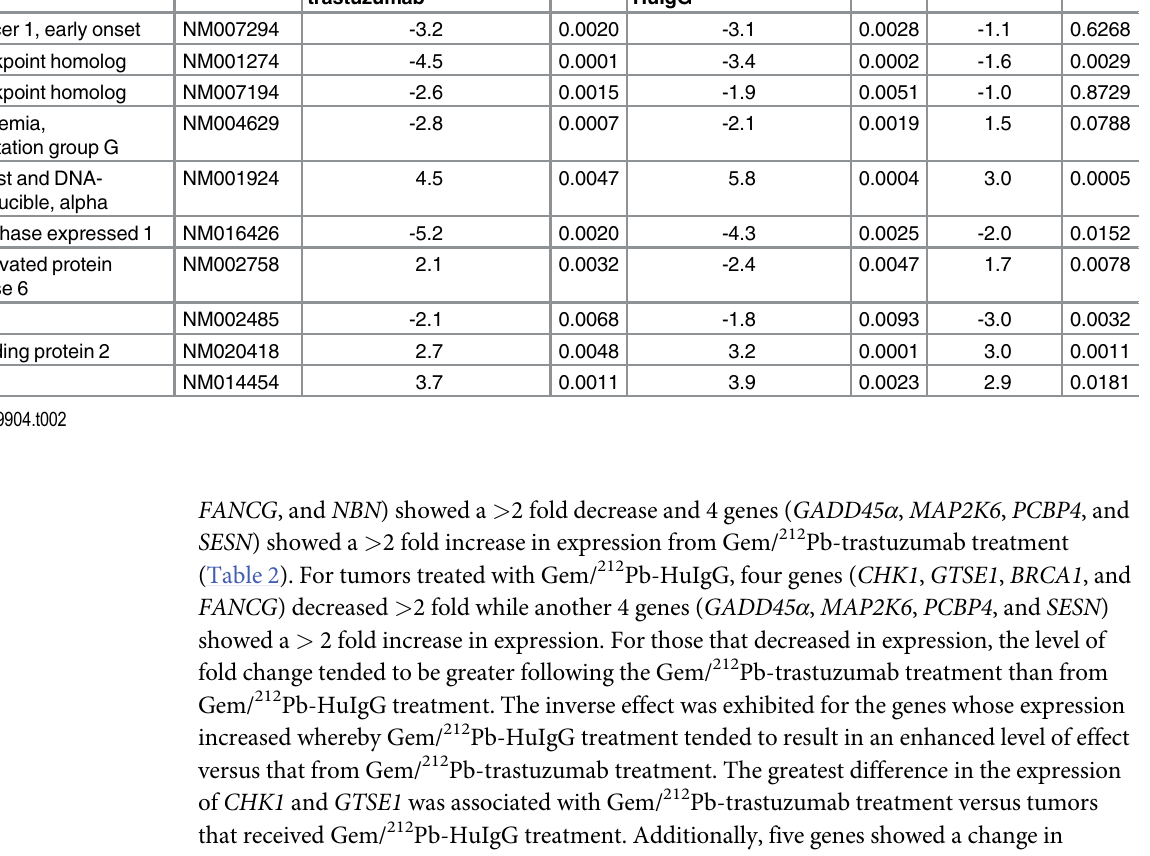
versus that from Gem/ 212 Pb-trastuzumab treatment. The greatest difference in the expression HuIgG treatments.